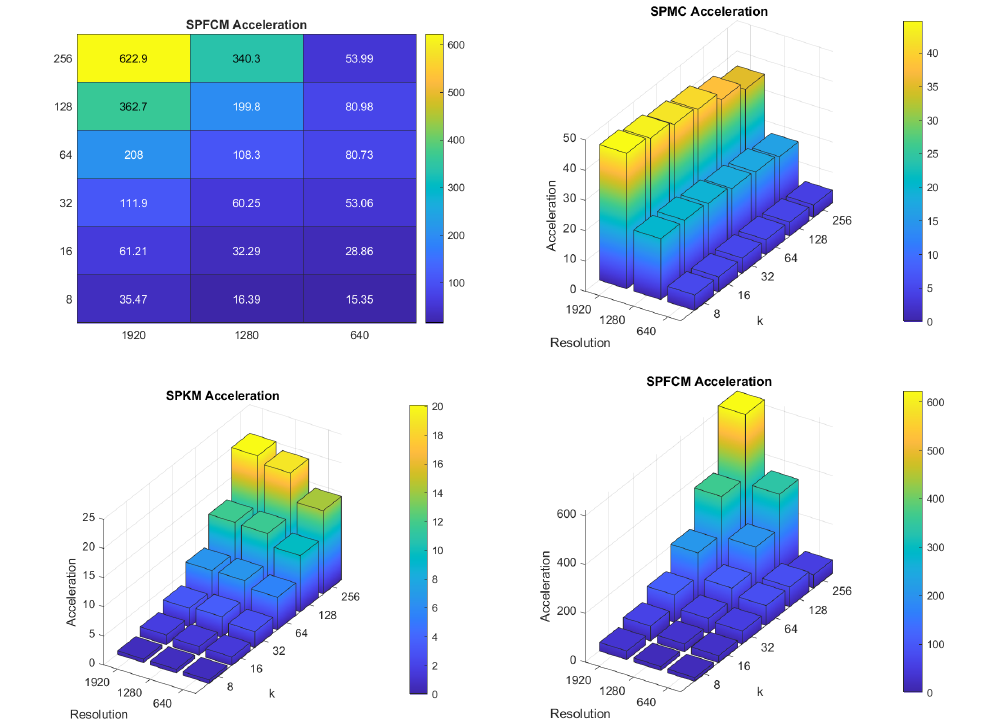
Figure 9. Computation rates of superpixel CQ algorithms for images of different